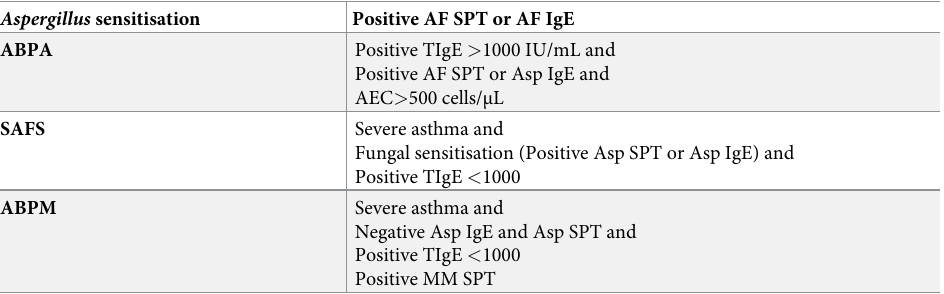
Table 1. Case definition for SAFS and